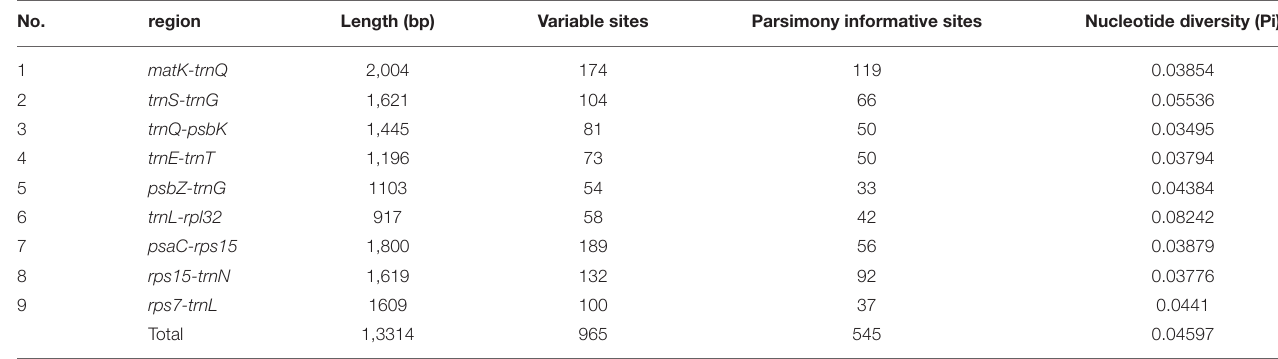
TABLE 5 | Nine hypervariable regions of cp genomes of Zygophyllum